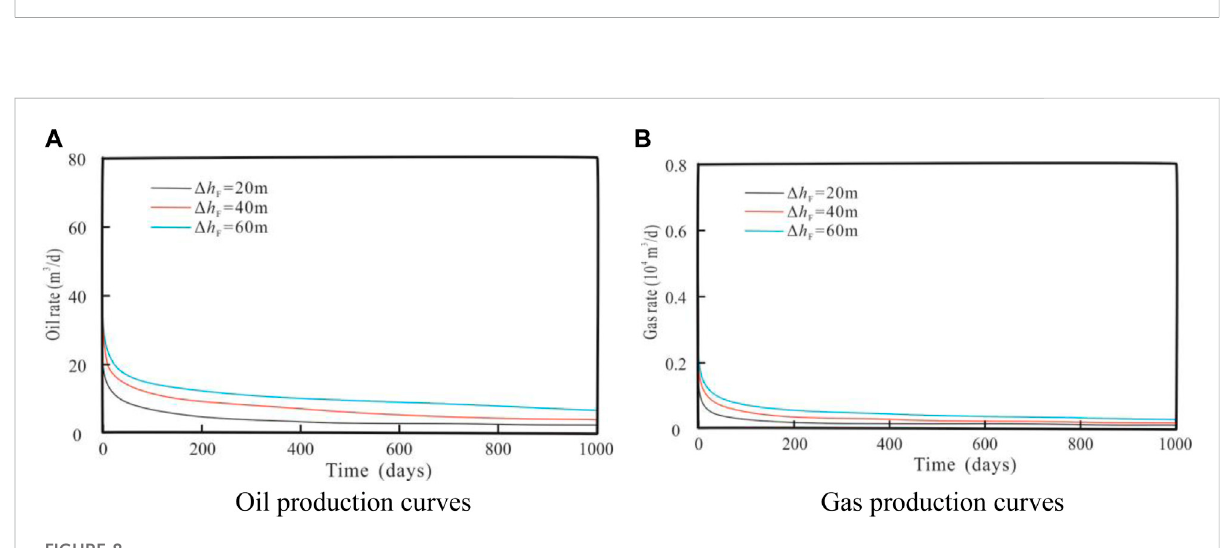
FIGURE 8 Effect of fracture half-height on production dynamic